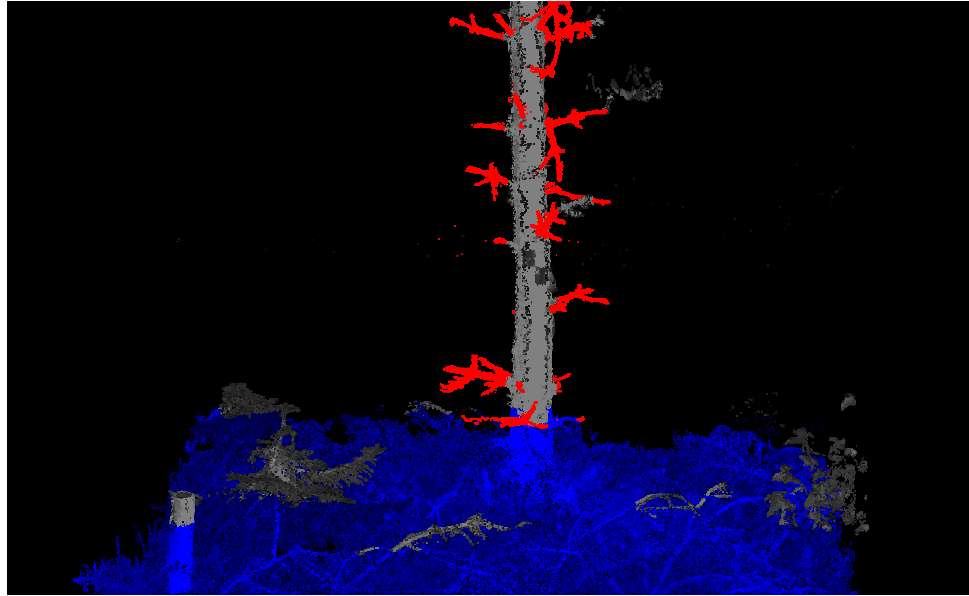
Figure 3. Preprocessing of pointcloud. Ground vegetation class in blue, near stem branches class in red, and unclassified points in